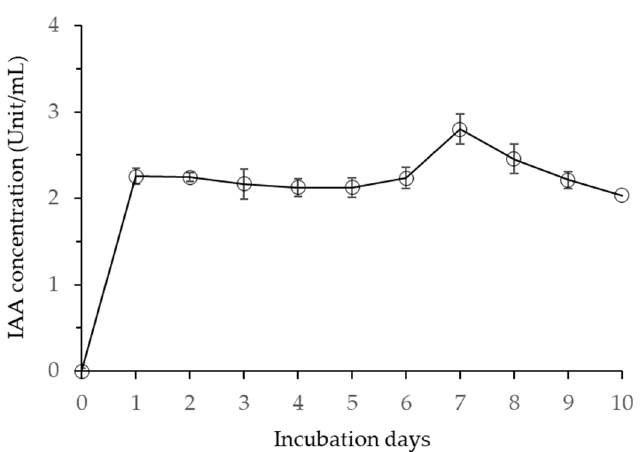
Figure 6. Indole-3-acetic acid (IAA) production by Bacillus velezensis CE 100 at 30 °C for 10 days. Error bars represent the standard deviation ( n = 3).